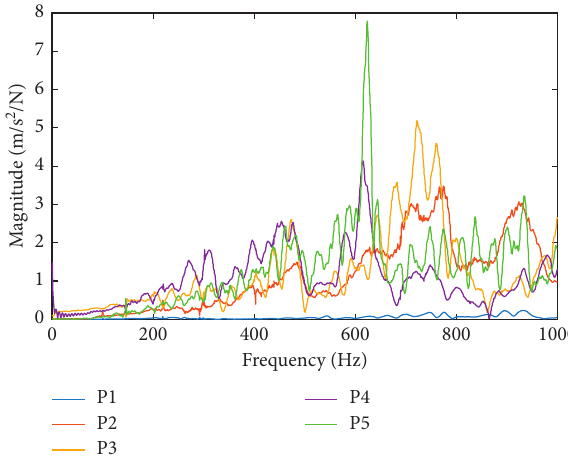
Figure 5: FRF curves of P1–P5 in the frequency domain.